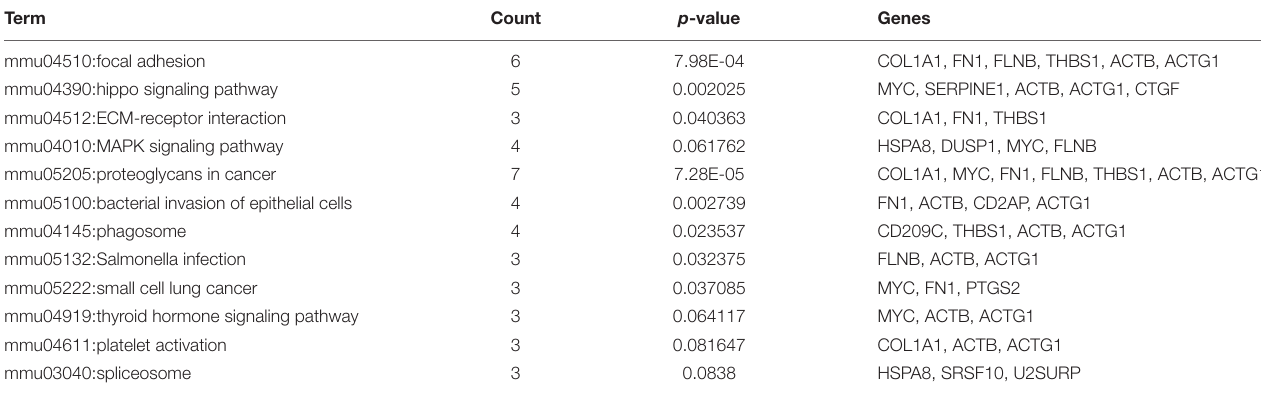
TABLE 7 | KEGG enrichment analysis on GC-1 and TM4 common deregulated genes. Term Count p -value Genes mmu04510:focal